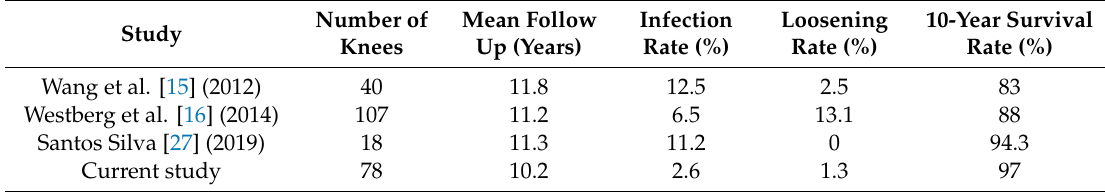
Table 8. Comparison of the long-term results of previously-reported TKA in hemophilic arthropathy